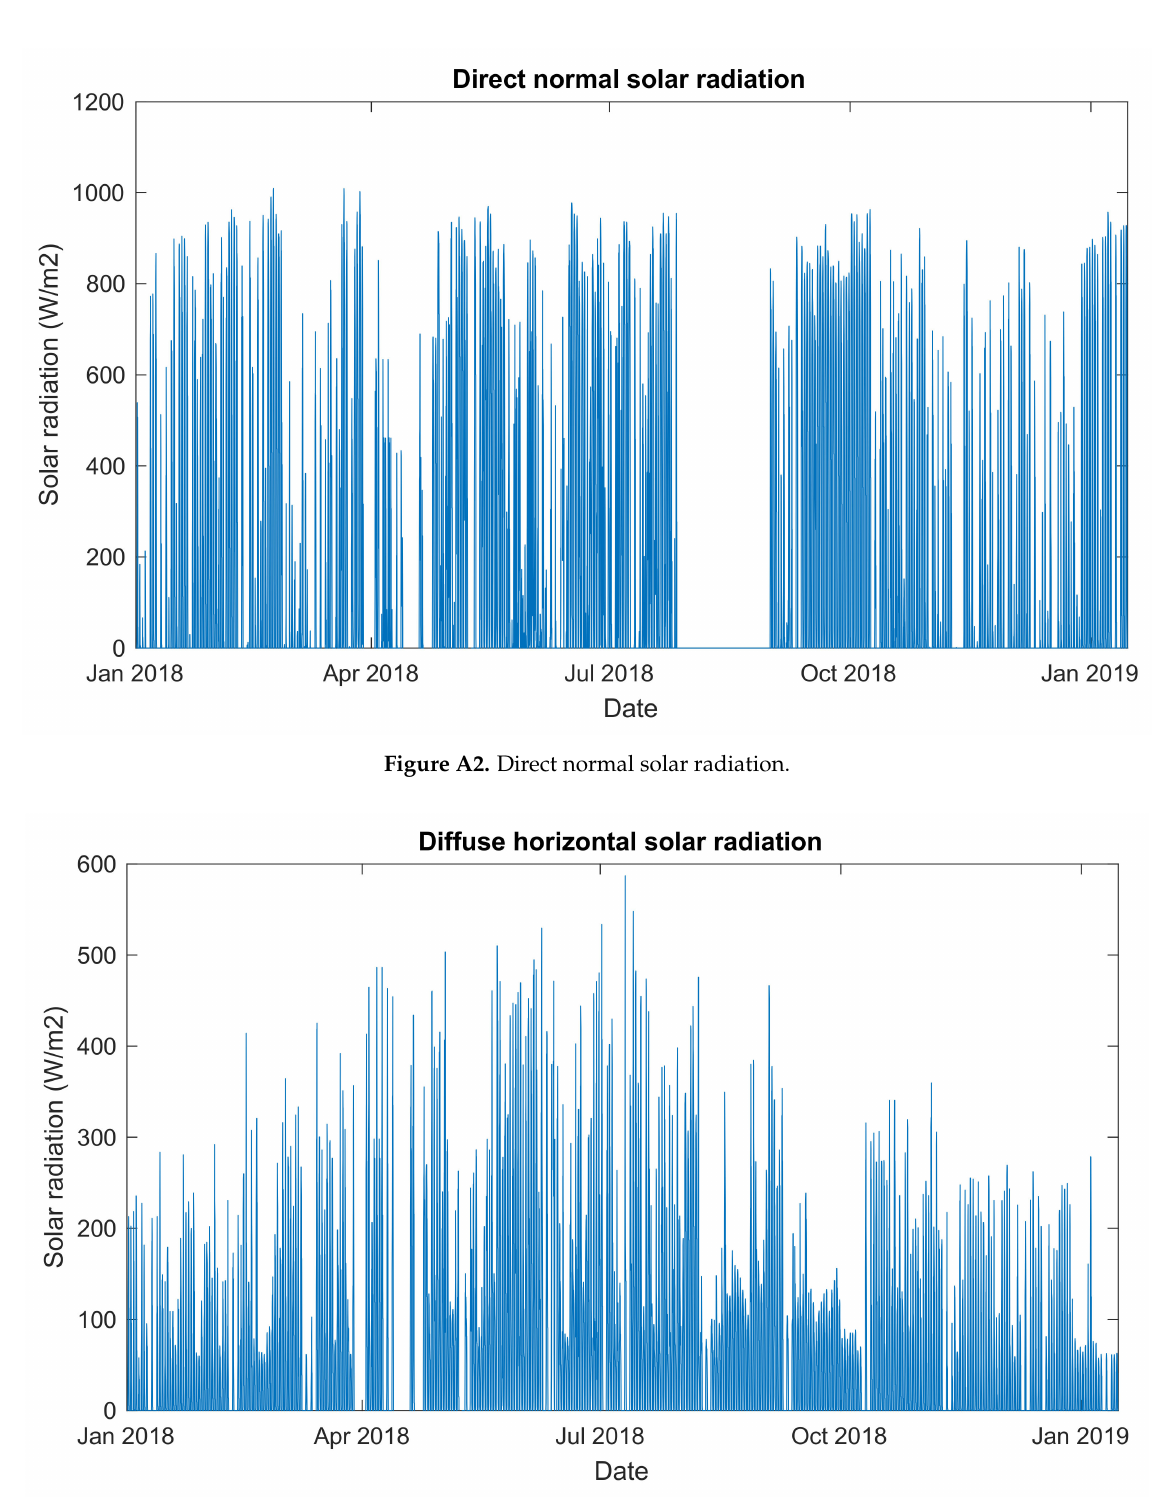
Figure A3. Diffuse horizontal solar